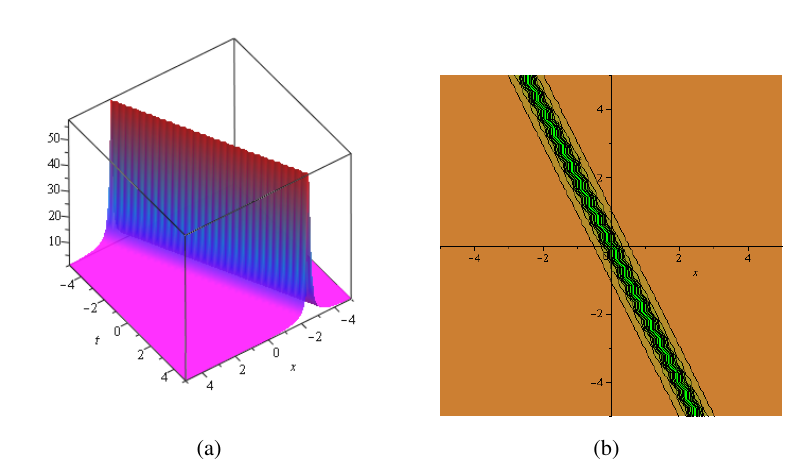
( x , t ) ) corresponding to the values 7